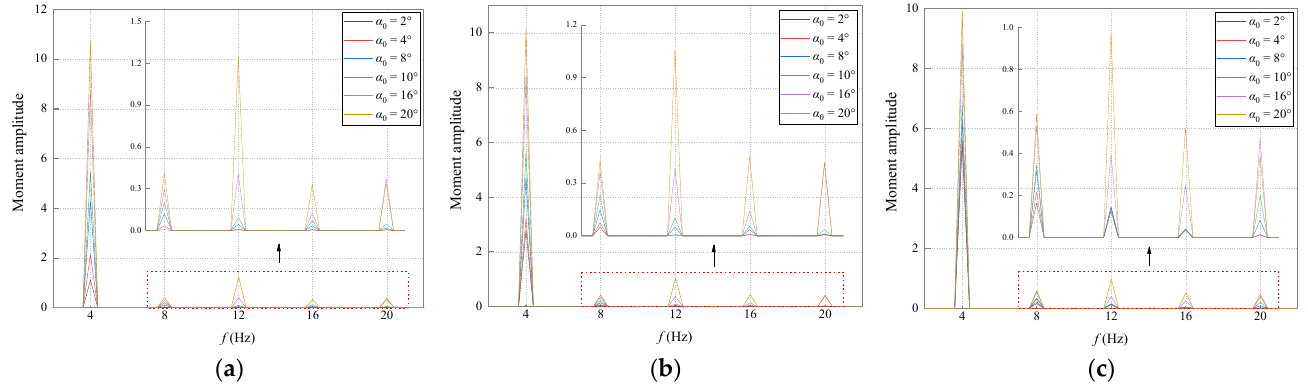
Figure 13. Aerodynamic moment spectrum under different coupled amplitude. ( a ) Heaving ampli- tude h 0 = 0.02 B ( b ) Heaving amplitude h 0 = 0.1 B ( c ) Heaving amplitude h 0 = 0.2 B .